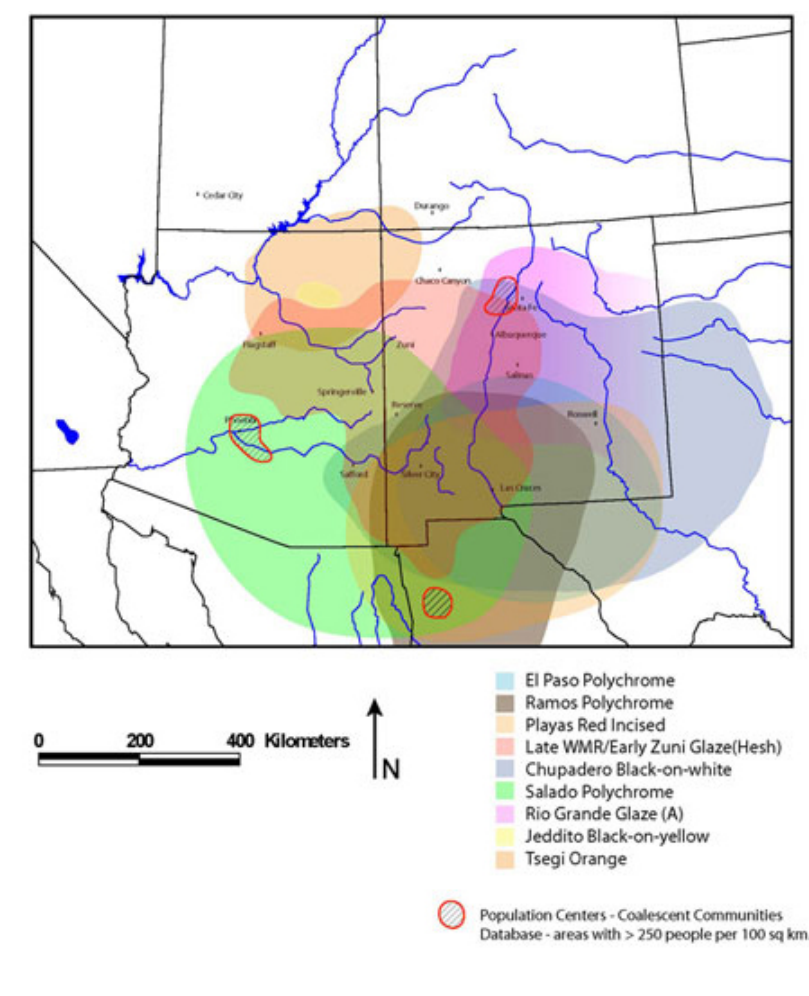
Fig. 8 . U.S. Southwest map showing the distribution of ceramic wares and of highest population concentrations, 1300